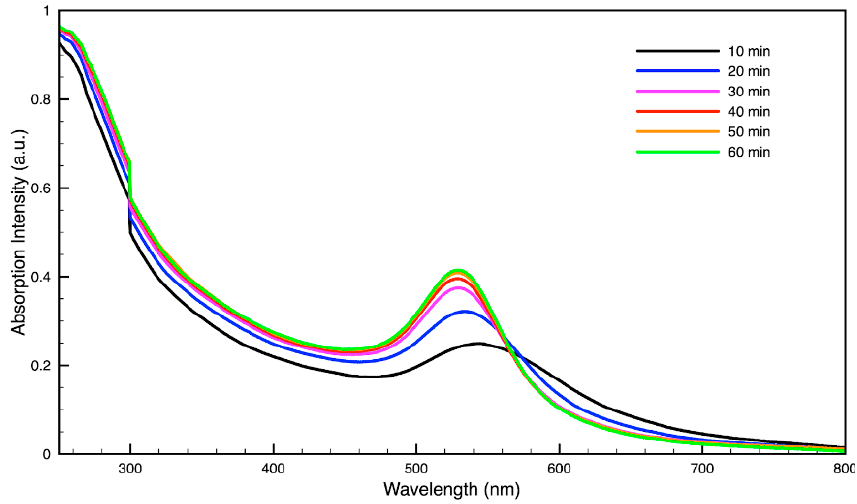
Figure 4. Time evolution of absorption spectrum of gold (Au) nanoparticles during synthesis using dark roast, spent espresso coffee grounds (SDE).